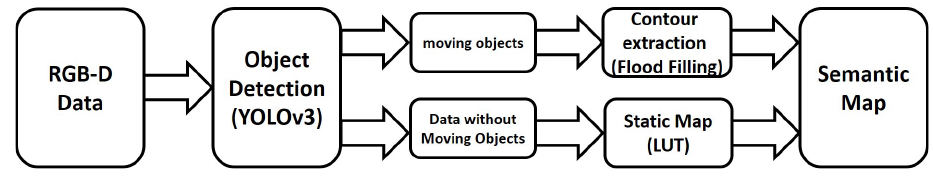
Figure 4. The overview of the proposed solution.